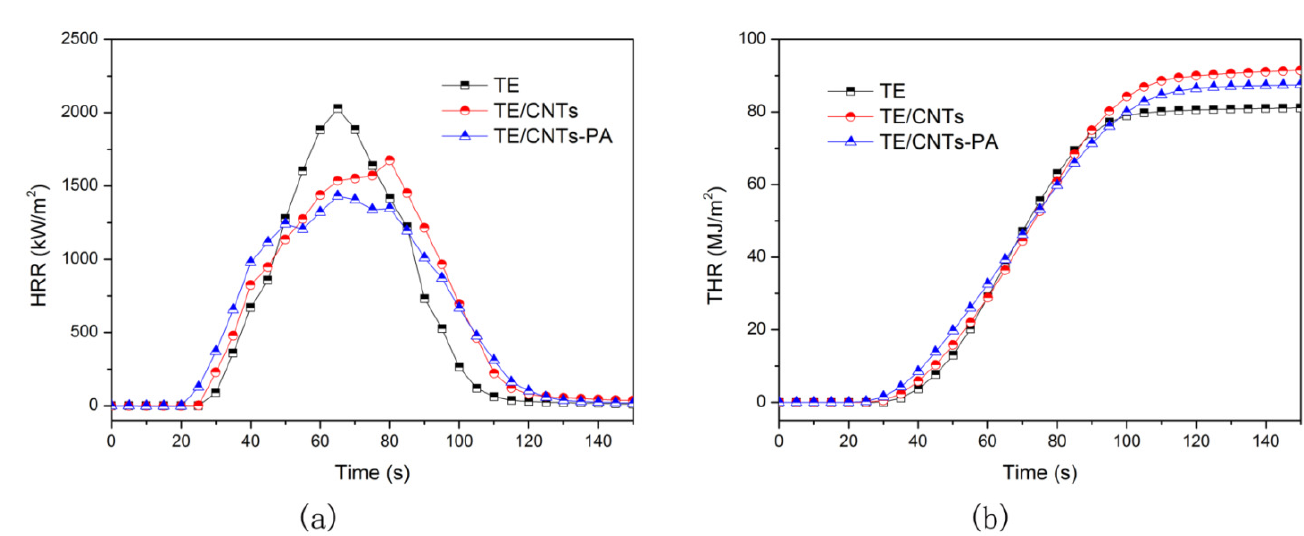
Figure 6. HRR ( a ) and THR ( b ) curves of TE and TE/CNTs-PA Figure 6 . HRR ( a ) and THR ( b ) curves of TE and TE/CNTs ‐ PA nanocomposites.